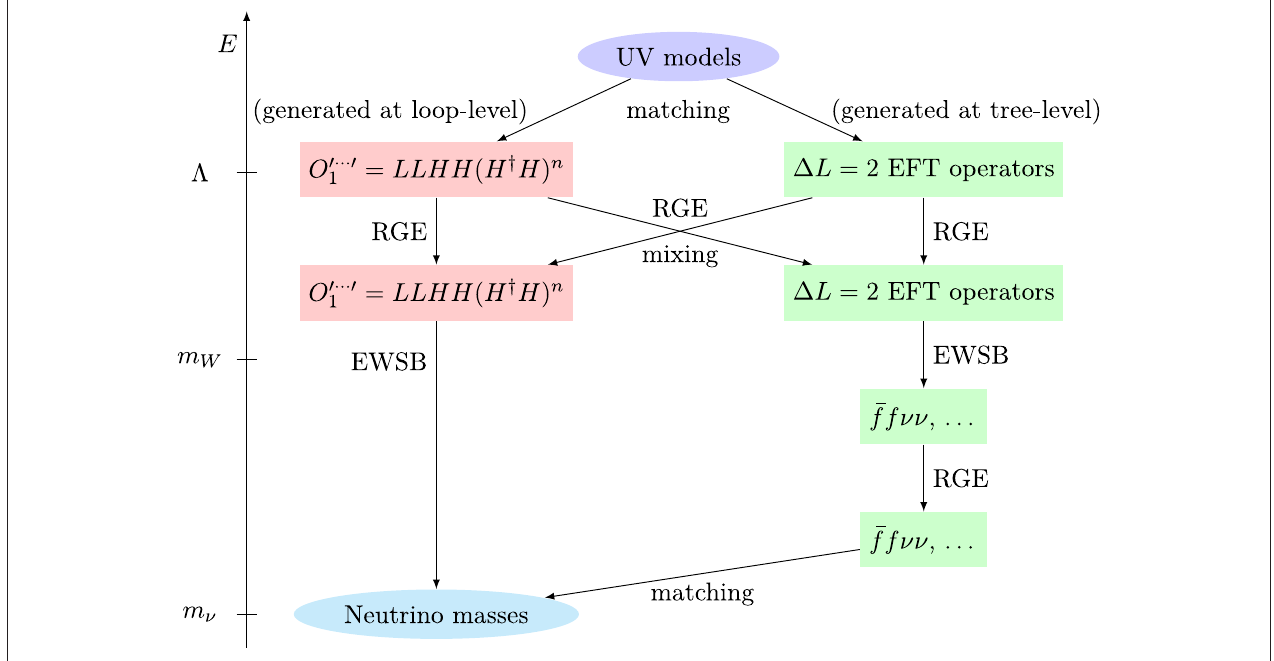
FIGURE 1 | Running and matching for (radiative) Majorana neutrino masses. See Appendix for a discussion of the relative contribution of the different